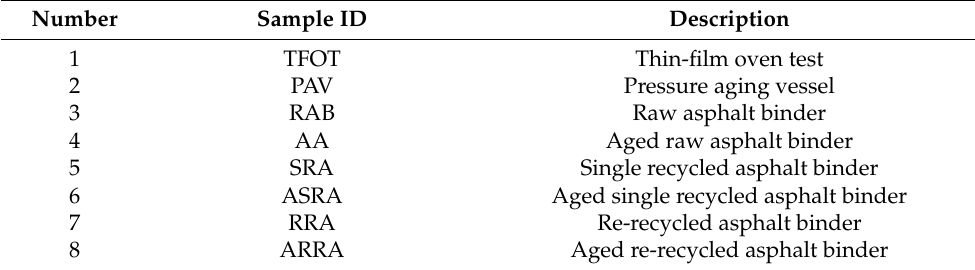
Table 2. Sample ID and corresponding